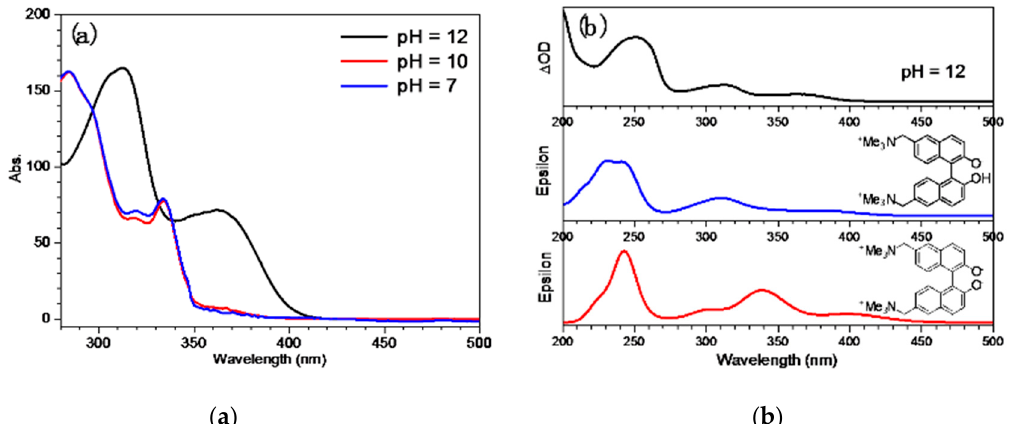
Figure 4. ( a ) UV-Vis spectra of BQMP-b in mixed solution with different pH values. ( b ) UV-Vis (top) and the BQMP-b calculated TD-B3LYP/6-311G(d,p) electronic spectrum of deprotonated species spectrum (top) and the BQMP-b calculated TD-B3LYP/6-311G(d,p) electronic spectrum of (middle and deprotonated species (middle and bottom).